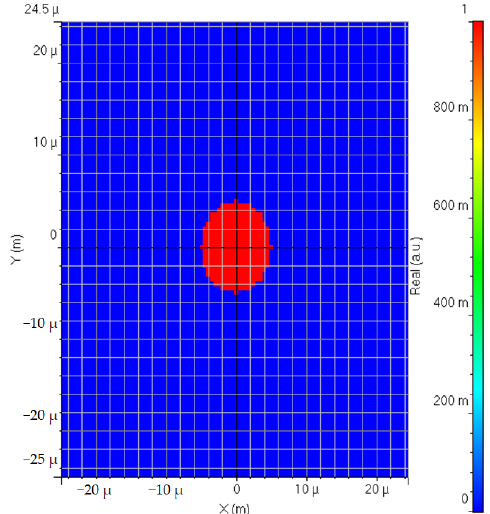
Figure 3. Generated donut mode 0 in MDM-PON system.